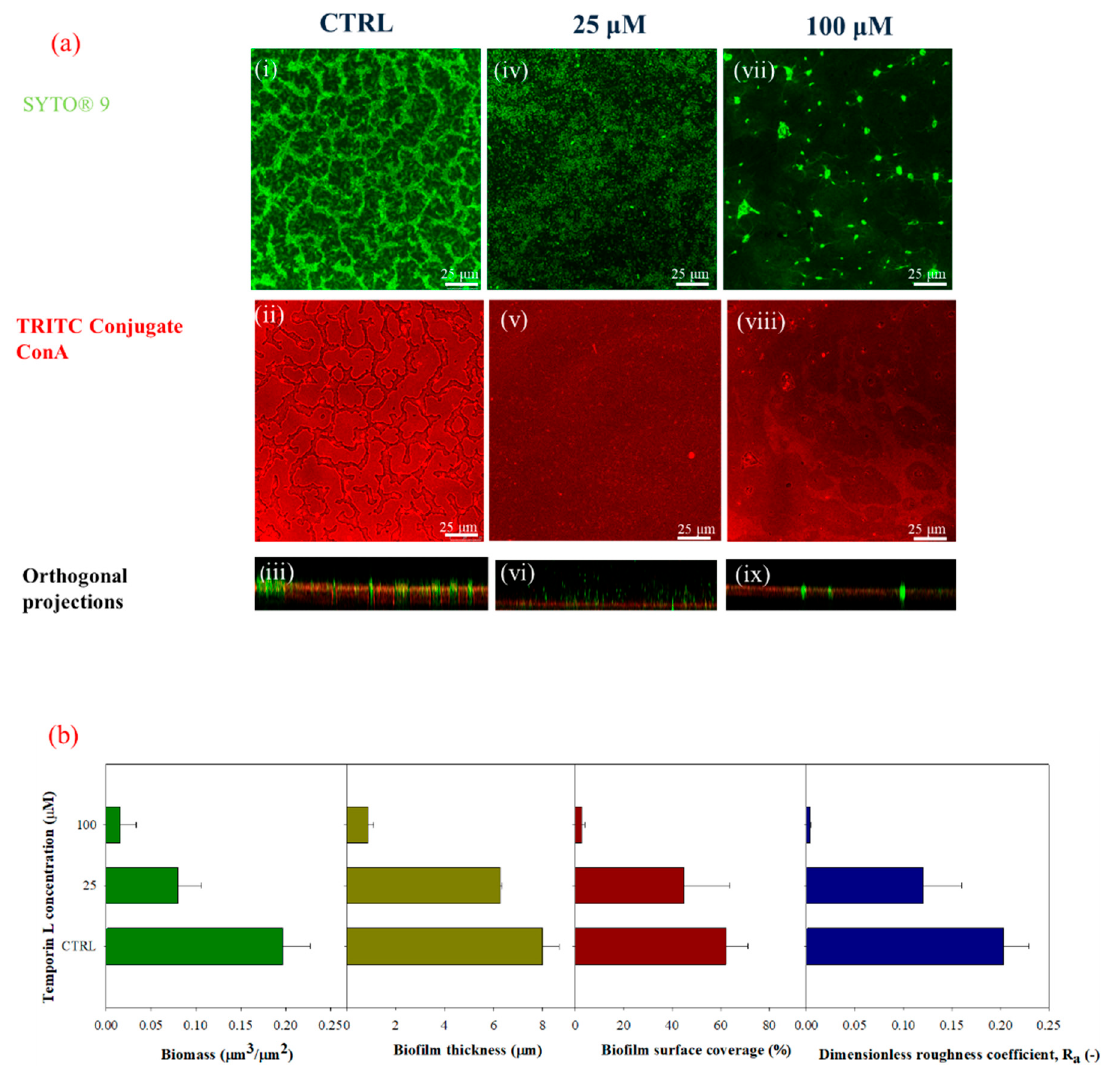
Figure 3. ( a ) CLSM images of 3 days-old-biofilms cultivated under in flow conditions in green (i, iv, and vii, SYTO ® 9staining, 3 μ L/mL), red channels (ii, v, and viii TRITC ConA, 100 μ g/mL) and orthogonal projections (iii, vi, and ix) upon TL treatment at two different concentrations (25 μ M and 100 μ M). (i–iii) CTRL (negative control), (iv–vi) 25 μ M, (vii–ix) 100 μ M. Experiments were carried out by dissolving TL in the bacterial suspension at the inoculation; 63X oil immersion magnification, scale bar = 25 μ m. ( b ) Morphological parameters were evaluated from CLSM stack images of untreated and TL-treated biofilms (25 and 100 μ M). TL was injected together with the bacterial suspension in the microfluidic system during the inoculation phase. Data were calculated from three independent measurements and are reported as average; the standard deviations are indicated.